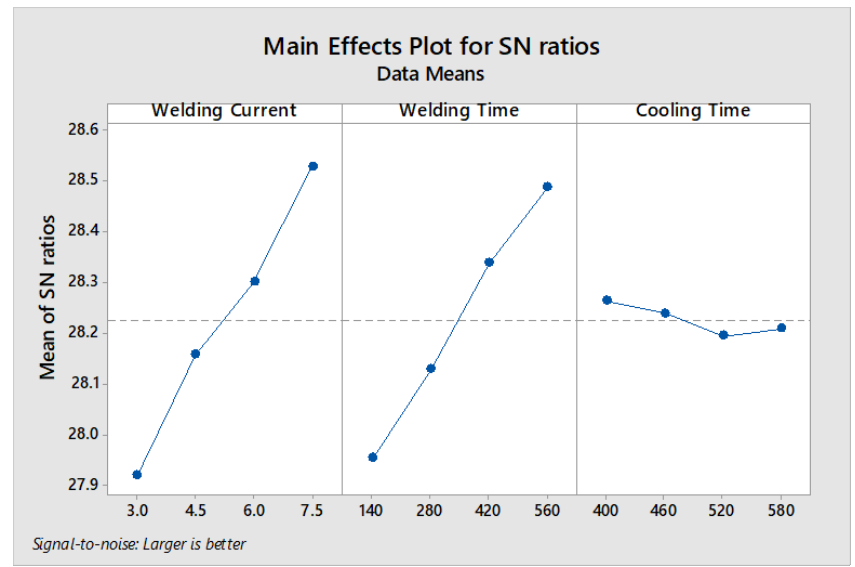
Figure 6. Graph representing main effects for peak load.